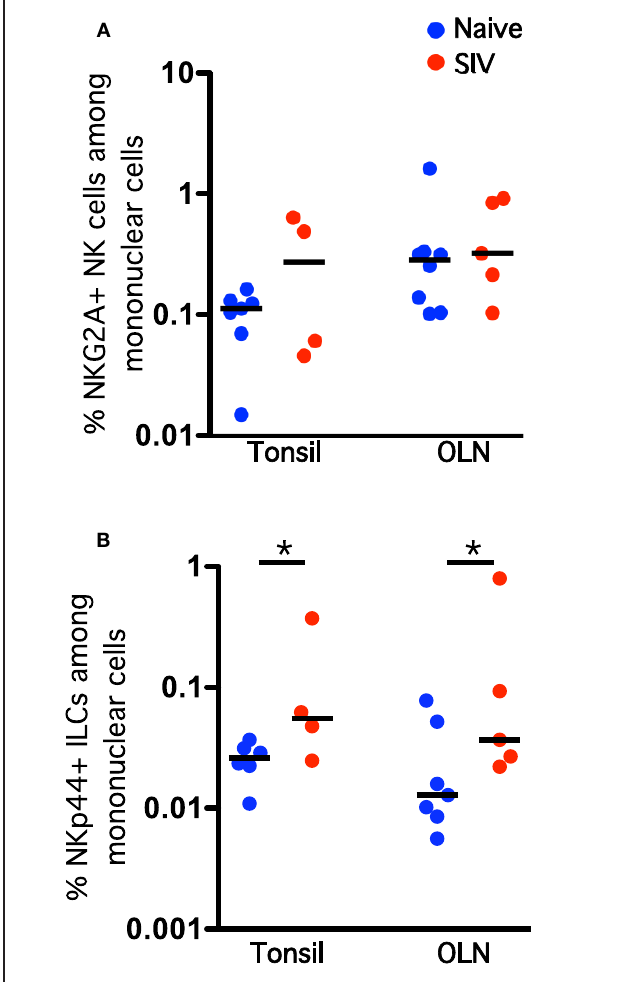
FIGURE 4 | Chronic SIV infection induces an expansion of NKp44 + ILC frequencies in the oral mucosa. Frequencies of NKG2A + NK cells (A) and NKp44 + ILCs (B) among live CD45 + CD3 − mononuclear cells in oral tissues of naïve and SIV-infected macaques. Horizontal lines indicate medians of 4–8 animals per group. Mann–Whitney U -tests were used for naïve-vs.-SIV comparisons; ∗ P < 0 .